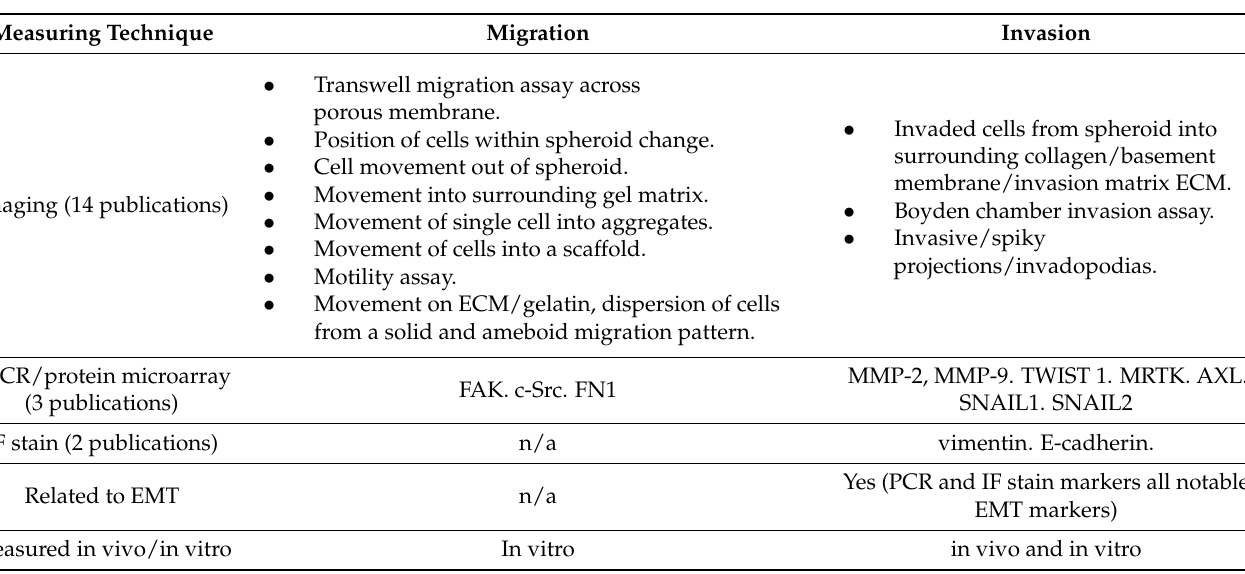
Table 3. Measurable markers of migration and invasion. Descriptors of migration are restrict to cell movement, whereas descriptors of invasion include the phrase “aggressive”. (IF- immunofluorescent. PCR- polymerase chain reaction). Measuring Technique Migration Invasion